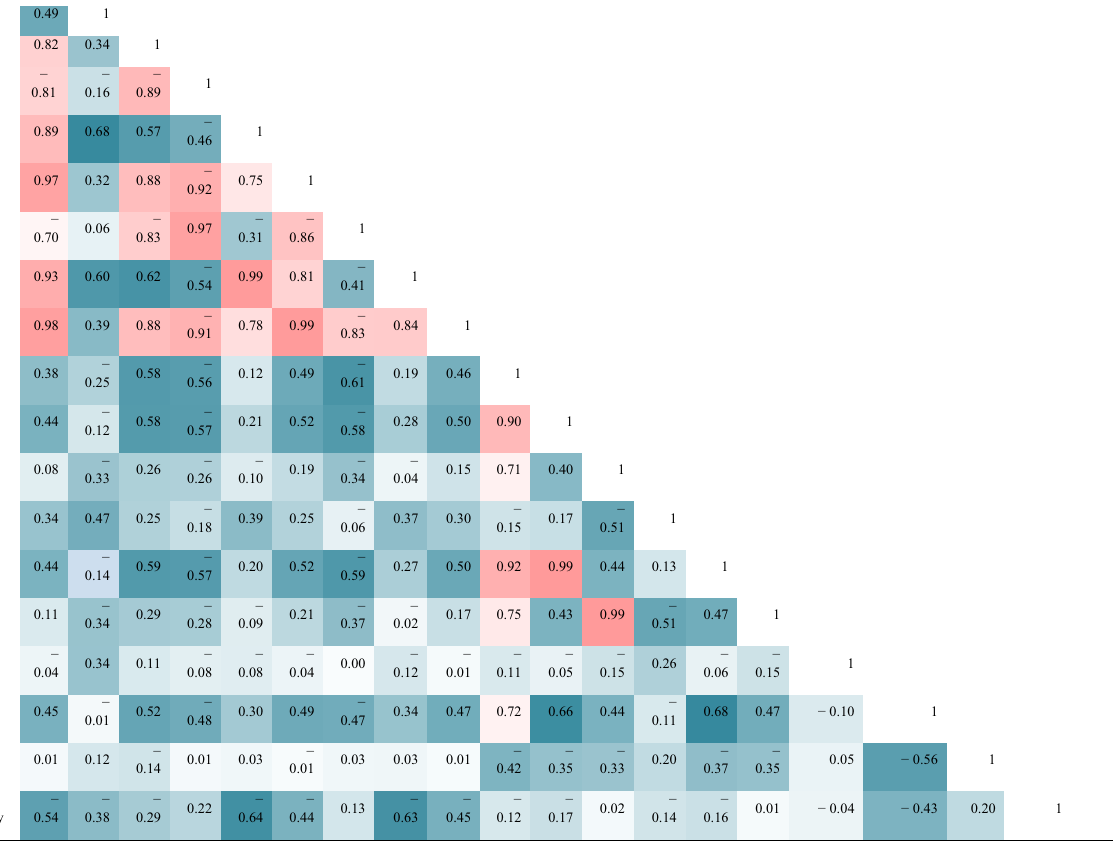
Table 2. Correlation between environmental variables for the final model of O. monoceros and O. rhinoceros . The depth-colored shading reflects the level of correlation between variables below 0.7 (blue) and more than 0.7 (including 0.7) (red).